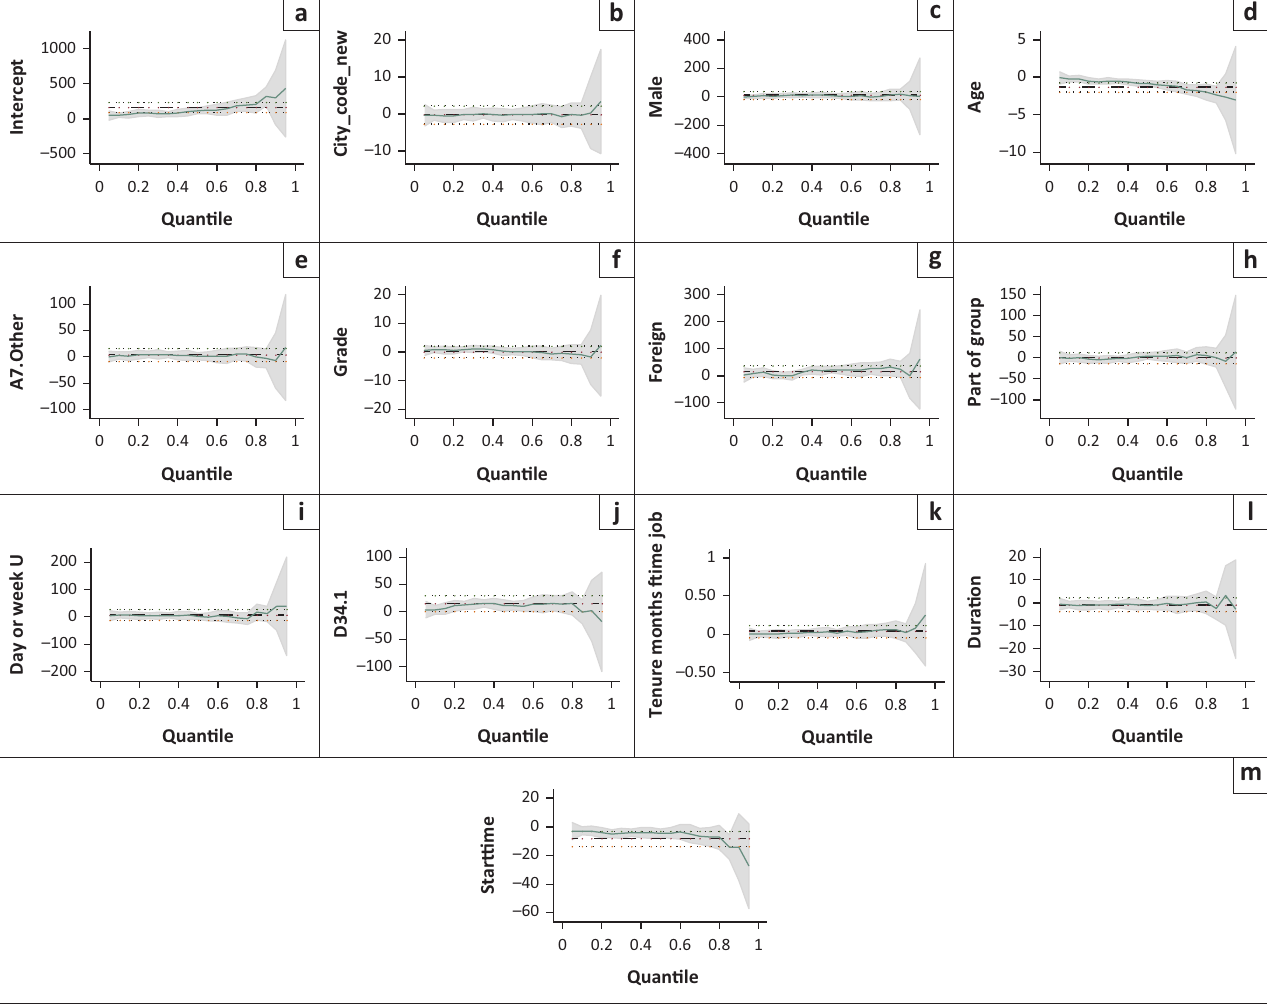
FIGURE 1-A2: Quantile plots for the selected